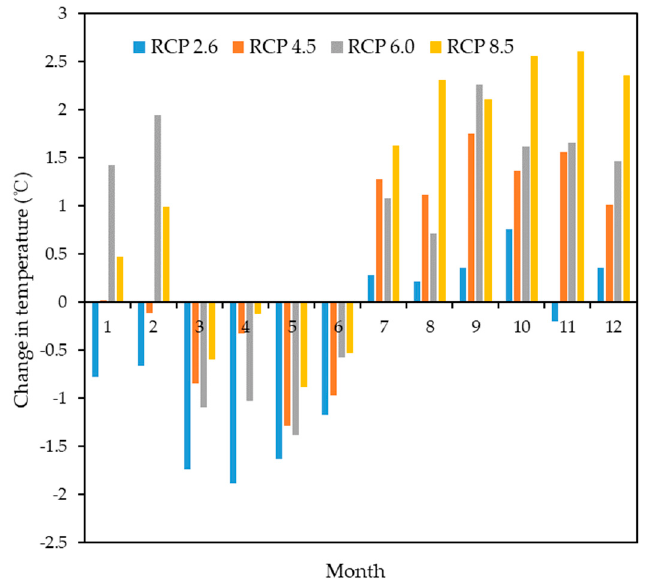
Figure 4. Monthly temperature changes for the 2050s under RCP 2.6, RCP 4.5, RCP 6.0 and RCP 8.5 emission scenarios compared with the base years (2006–2016).